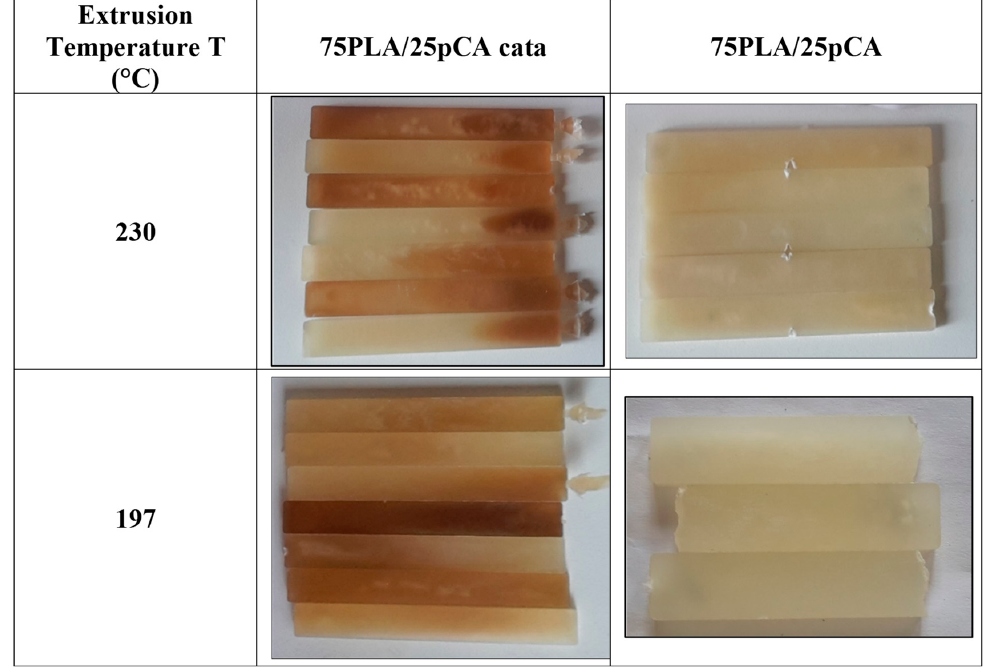
Figure 2. Specimens’ color after extrusion and injection moulding.